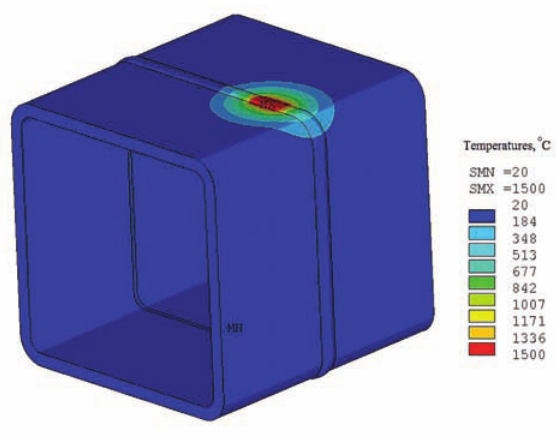
Fig. 10. Temperature distribution fields after 3 s from welding simulation has